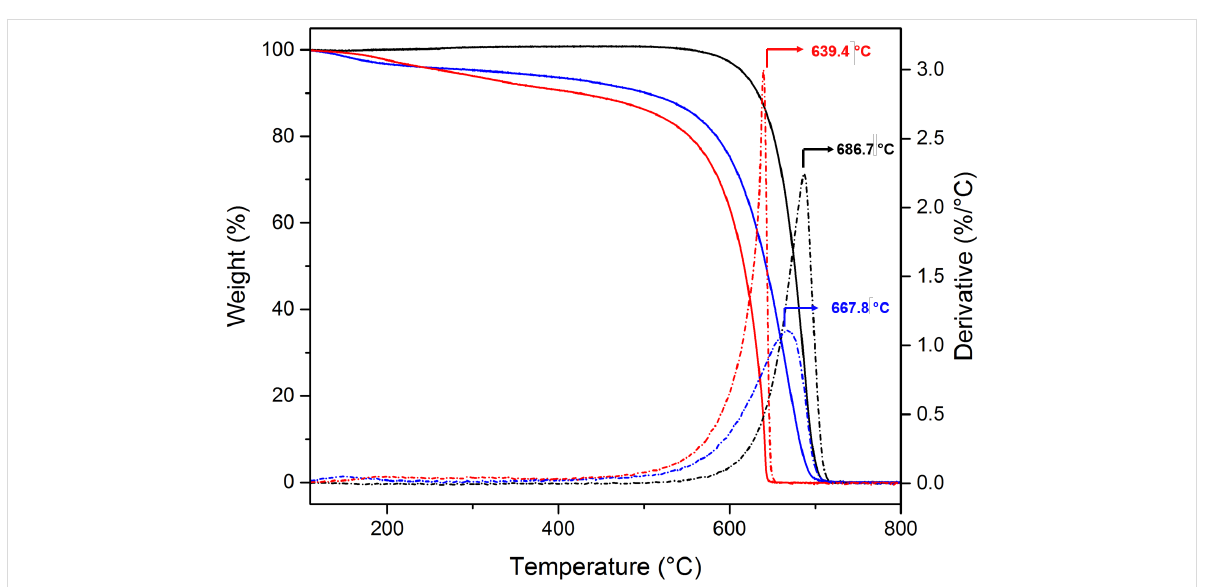
Figure 3: Thermogravimetric analysis (TGA) spectra of the functionalized CNOs. TGA (solid lines) and the corresponding weight loss derivatives (dotted lines) of p-CNOs (black), oxi-CNOs (blue) and fluo-CNOs (red). All experiments were run in air at a temperature rate of 10 °C min − 1